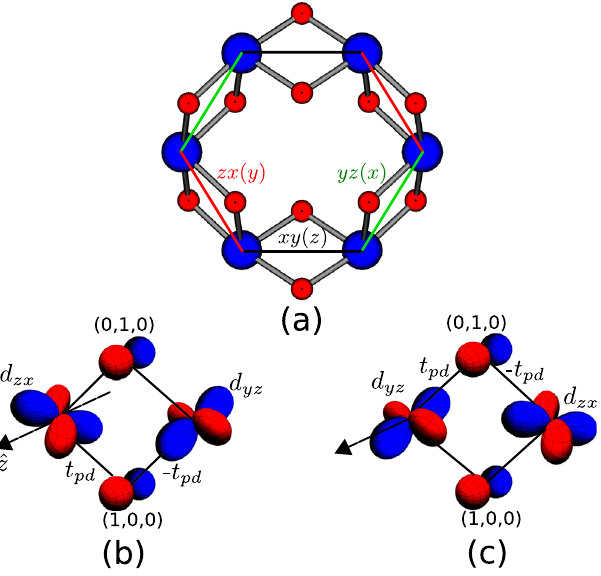
Fig. 1 Schematics for the edge-shared iridates/ruthenates. Panel ( a ) shows the full edge-shared hexagon realized in materials. Here blue and red circles indicate transition metal (TM) and ligand sites, respectively. Panels ( b ) and ( c ) show the hopping channels for the z -bond mediated by the oxide/chloride [ligand atoms] p orbitals. Note that only d yz and d zx orbitals can hop via the ligand p z orbitals at (1,0,0) and (0,1,0), respectively. In addition, only the upper and lower hopping paths in ( b ) and ( c ), respectively, are